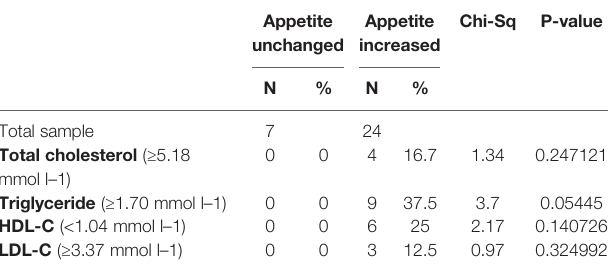
TABLE 3 | Dyslipidemia de fi ned by each single outcome measurement in appetite increased and unchanged